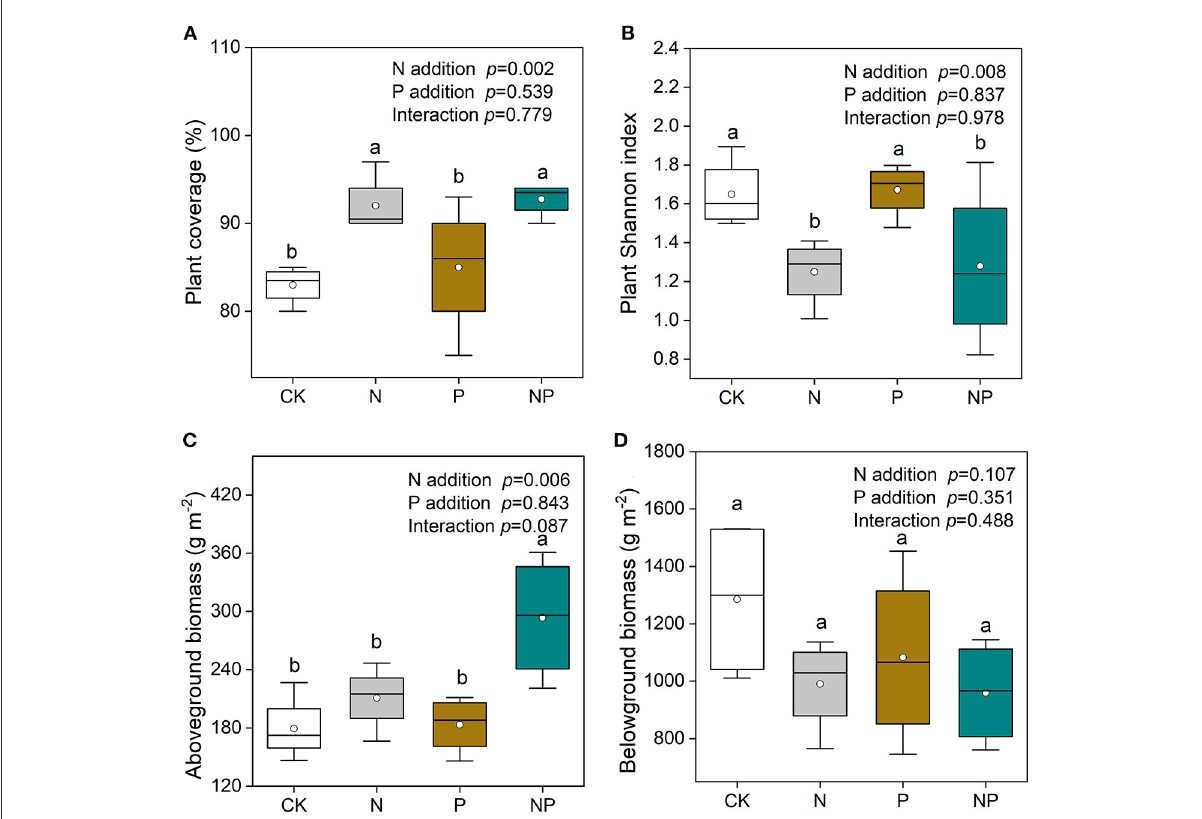
FIGURE2 (A) The variation of plant coverage, (B) plant Shannon index, (C) total aboveground biomass, and (D) total belowground biomass under different nutrient additions. Values are means with SE ( n = 0.4). Different lowercase letters represent significant difference among treatments determined by LSD-test ( P = 0.05). CK, the control; N, nitrogen addition; P, phosphorous addition; NP, the combined addition of nitrogen and